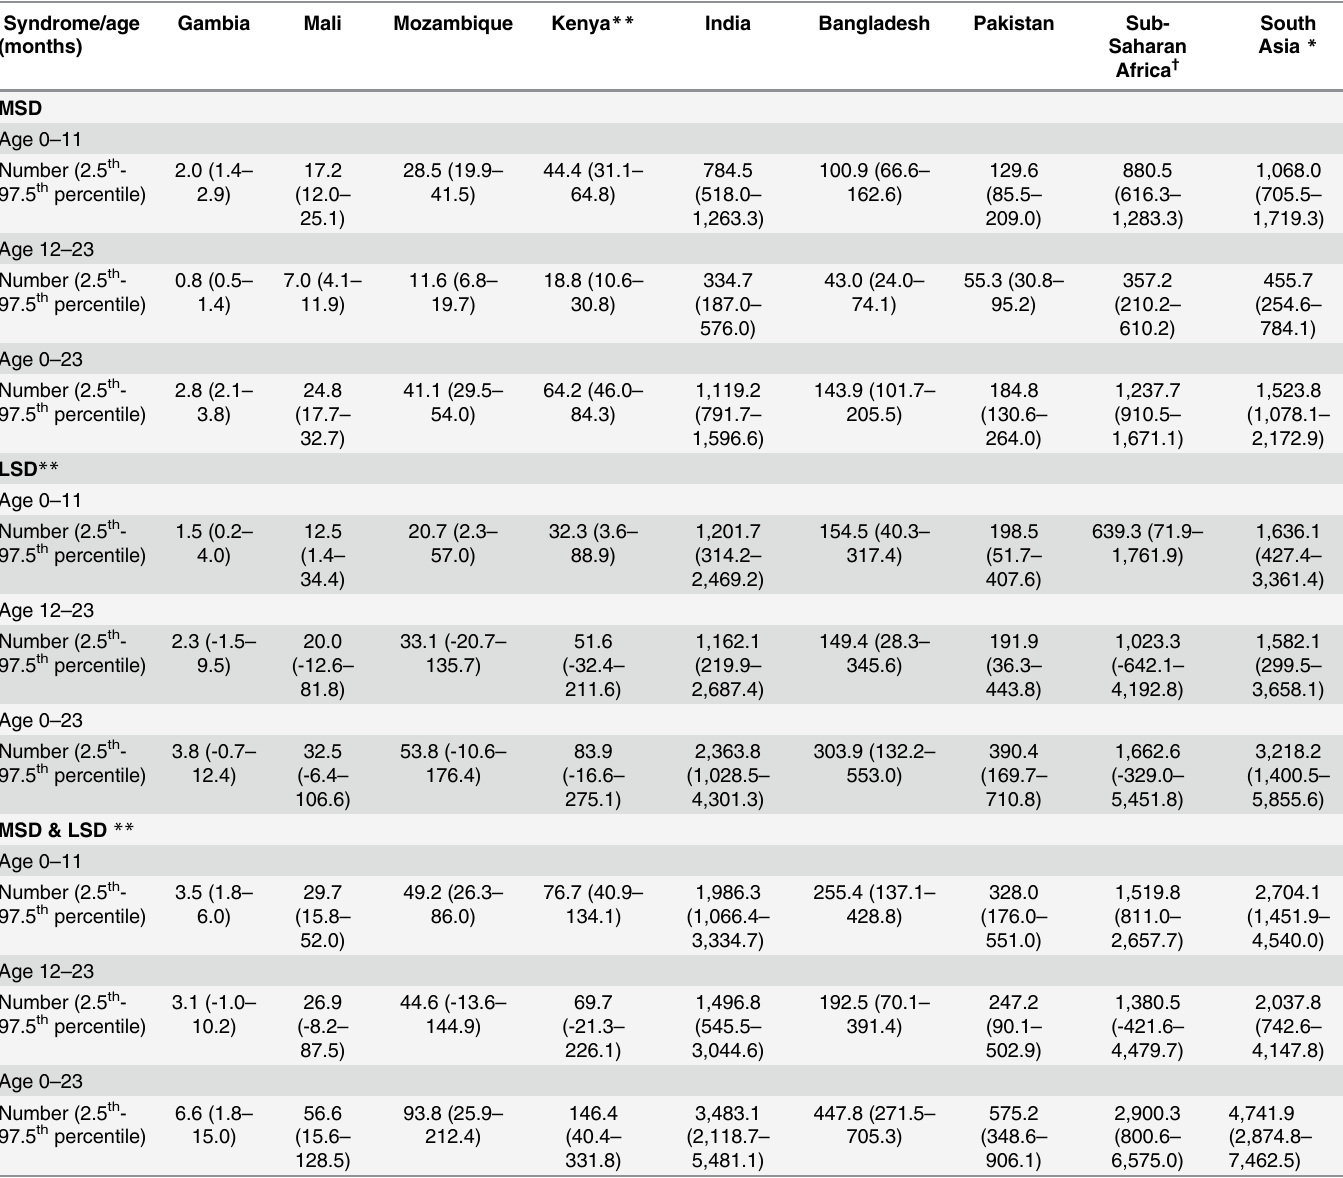
Table 4. Estimated number (in thousands) of diarrhea cases attributable to Cryptosporidium by age, country and region § . Syndrome/age